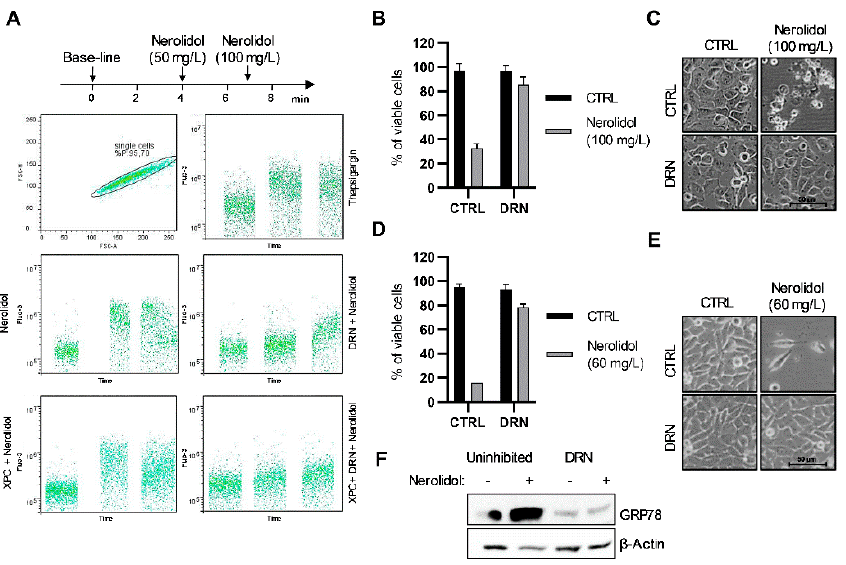
Figure 3. Nerolidol cytotoxicity originates from Ca 2+ depletion in the ER through ryanodine receptor (RYR). ( A ) Determination of cytoplasmic Ca 2+ level by labelling with the Fluo-3 Ca 2+ stain and measured by flow cytometry. Single-cell suspension of TCCSUP cells was prepared in Ringer solution (containing Ca 2+ ) for thapsigargin treatment and PBS (without Ca 2+ ) for nerolidol treatments. Cells in PBS were pre-treated for 1 h with XSC (380 nM), DRN (10 μ M), or their combination. Base-line Ca 2+ level was determined for each combination followed by administration of 50 mg/L of nerolidol. An additional dose of 100 mg/L of nerolidol was administered in order to provoke a maximal increase in Ca 2+ level in the cytoplasm. Thapsigargin was used as a positive control. ( B ) Cell viability of T24 cells pre-treated with DRN (10 μ M) for 1 h and then treated with 100 mg/L of nerolidol for 2 h determined by cell counting and trypan blue staining. Cell counts were normalized to control cells. ( C ) Cell microscopy images of T24 cells pre-treated with DRN (10 μ M) for 1 h and then treated with 100 mg/L of nerolidol for 2 h. ( D ) Cell viability of T24 cells pre-treated with DRN (10 μ M) for 1 h and then treated with 60 mg/L of nerolidol for 48 h determined by cell counting and trypan blue staining. Cell counts were normalized to control cells. ( E ) Cell microscopy images of T24 cells pre- treated with DRN (10 μ M) for 1 h and then treated with 60 mg/L of nerolidol for 48 h. ( F ) T24 cells treated with DRN (10 μ M) for 1 h before nerolidol treatment (60 mg/L 24 h). Immunostaining of GRP78 was used to investigate the inhibitory effect on ER stress induction. The uncropped blots and molecular weight markers are shown in Supplementary File S1